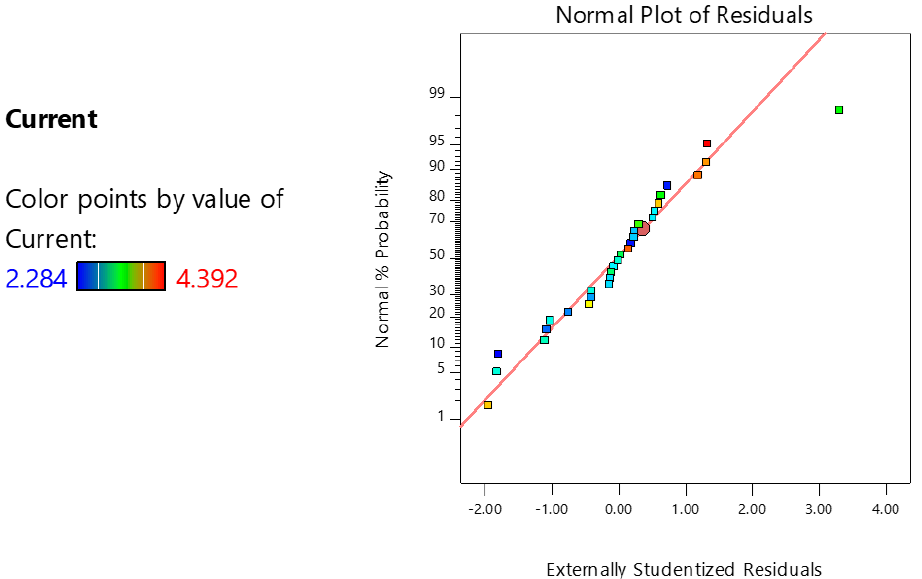
Figure 6. Normal probability plot for residuals.